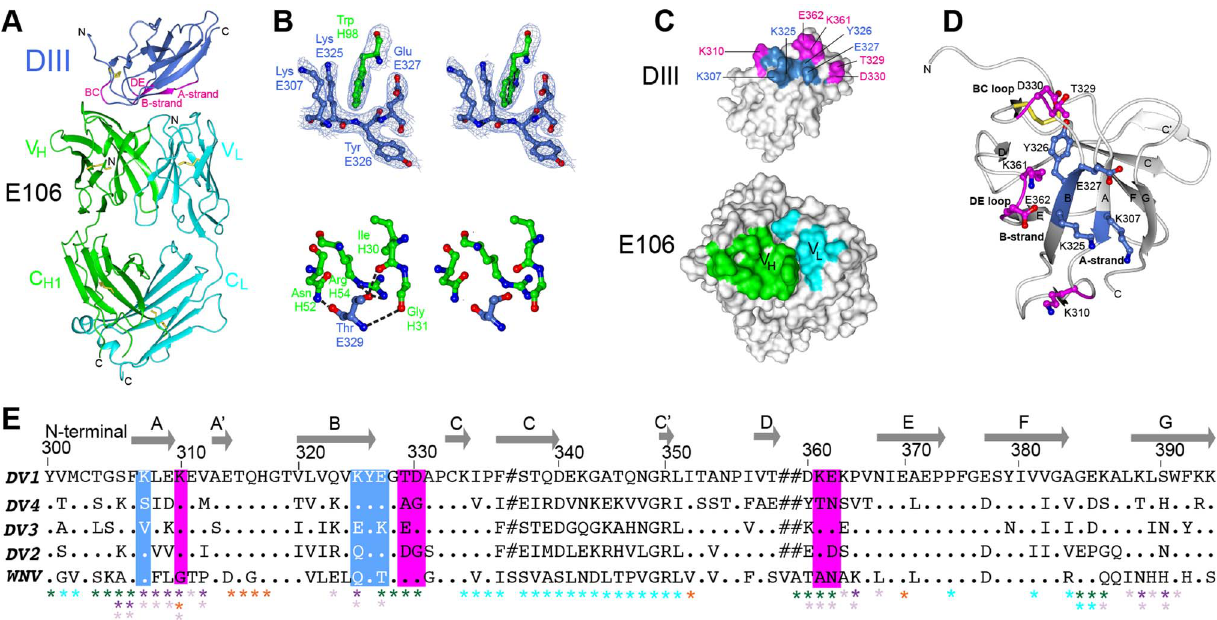
Figure 1. Crystal structure of E106 Fab in complex with DENV-1 E DIII. ( A ) The E106 Fab epitope on DENV-1 E DIII is comprised of residues in the A-strand (K307 and K310), the end of the B-strand (K325 and Y326), and the connecting BC (E327, T329, and D330) and DE (K361 and E362) loops. The immunoglobulin-like DIII is shown in blue (epitope regions in magenta), with the E106 heavy chain in green and light chain in cyan. ( B ) Heavy chain residue W98 binds in a deep pocket contributed by the aliphatic groups of side chain DENV-1 E DIII residues K307, K325, and E327 and main chain of Y326, in stereo (top panel). The electron density map is contoured at 1.1 s . Ball and stick representation of the molecular interactions involving T329 (the residue that escapes neutralization [13] in stereo (bottom panel). ( C ) Surface representation of DENV-1 E DIII (top) and E106 Fab (bottom) highlighting residues making direct contacts in the complex (see Table S1). DENV-1 E DIII residues previously identified by yeast surface display are displayed in magenta [13]. ( D ) The structural epitope on DENV-1 DIII is shown in ribbon representation. ( E ) Sequence of DIII of DENV-1 aligned with that of DENV-2, -3, -4 and WNV highlighting the E106 structural epitope, which is conserved in DENV-1 genotypes but not DENV serotypes or WNV. Identical residues are represented by a dot, deleted residues by a hash. For comparison, The DIII structural epitopes of WNV E16, DENV-2 1A1D-2, DENV cross-reactive 4E11 and 2H12 MAbs and DENV-1-E111 contact residues are labeled with green, purple, light purple, orange and cyan asterisks respectively